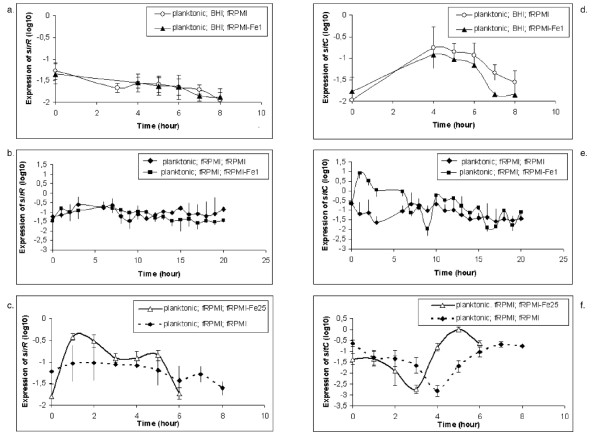
In vitro gene expression of sirR (a, b and c) and sitC (d, e and f) in planktonic bacteria. Gene expression is quantified as log10 (cDNA/gDNA) in the y-axis. The line that links the data points helps to clarify the results at each time point measured. The error bars represent standard deviations. Fifteen samples from three independent cultures were assessed at each time point. Time is given in hours in the x-axis. (a) and (d): bacteria pre-incubated overnight in BHI and incubated in fRPMI (full line with empty circle) or fRPMI-Fe1 (full line with filled triangle). (b) and (e): bacteria pre-incubated overnight in fRPMI and incubated in fRPMI (full line with filled diamond) and in fRPMI-Fe1 (full line with filled square). (c) and (f): bacteria pre-incubated overnight in fRPMI and incubated in fRPMI (dotted line with filled diamond) or in fRPMI-Fe25 (full line with empty triangle).